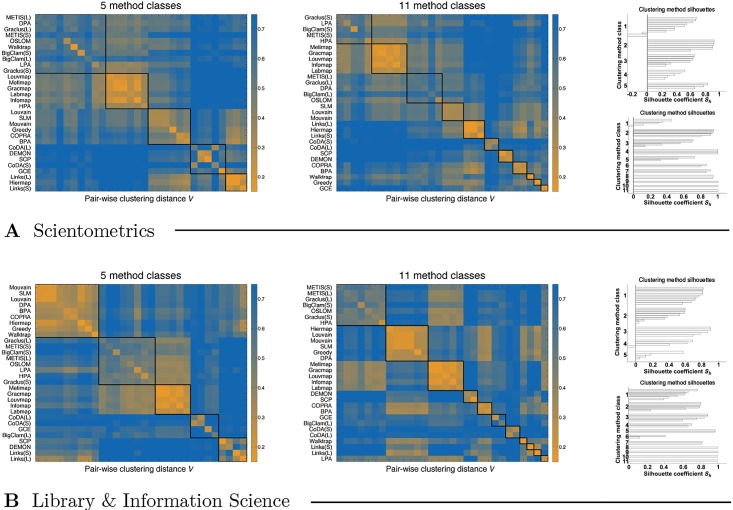
Pair-wise distances between the clusterings obtained by the considered methods.Panel A shows the heatmaps of clustering distances for the Scientometrics citation network, where the methods are clustered into 5 and 11 classes (left- and right-hand side, respectively). Note that this merely implies the ordering of the rows/columns. Insets on the right show the method silhouette coefficients. Panel B shows the same for the Library & Information Science citation network. See Methods for the definition of the clustering distance and text for the details of the method clustering procedure.